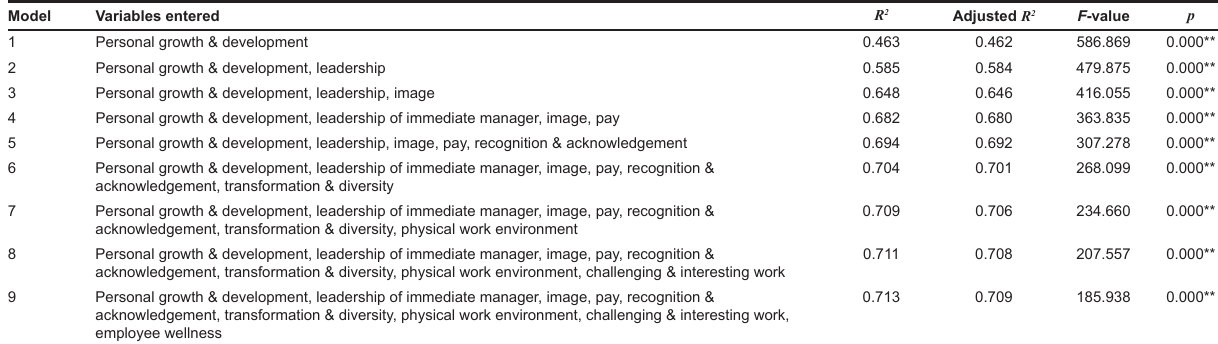
Table 7 Model summary + of explained variance in job